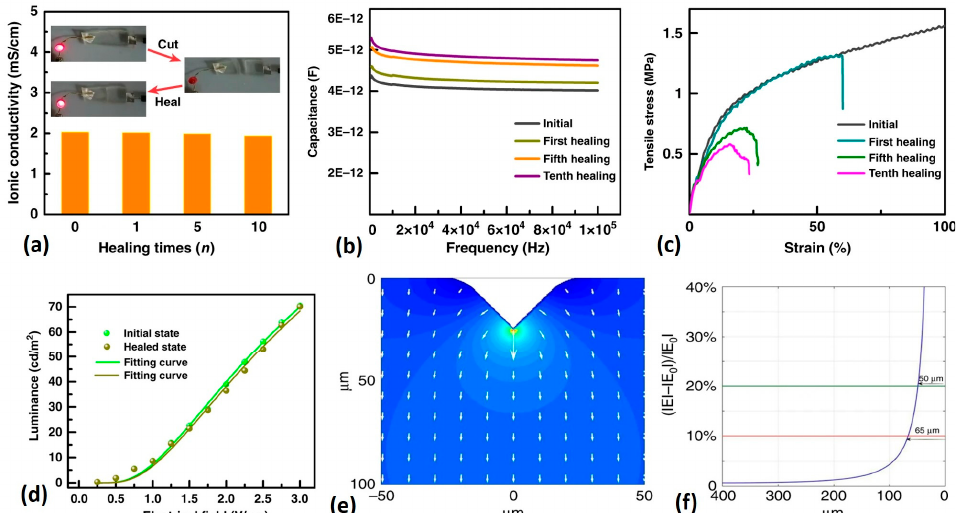
Figure 5. Self-healing and light-emitting performance of electroluminescence devices produced based on polyacrylic acid (PAA)-based hydrogels. ( a ) Ionic conductivity of PAA conductor after lots of cutting and healing times, showing almost full restoration of ionic conductivity after healing. ( b ) Dielectric capacitance after lots of healing and cutting times, which restored dielectric permittivity and capacitance and revealed that light-emitting intensity remains constant after healing. The capacitance of the dielectric layer remained constant after various healing cycles with only a 16.8% increase in capacitance at 1000Hz. ( c ) Mechanical performance of the EL device with the same healing–cutting times shows restoration of 537 kPa in tensile strength and 2.4 MPa in Young’s modulus. ( d ) Voltage-luminescence performance of the EL device at the very beginning states showing high mechanical strength and good flexibility. ( e ) Distribution of the electrical field across the pigment layer (magnified image), showing that the electrical field variation dispersed within the space span. ( f ) Variation in the electric field. Re-printed from an open- access article under the terms of Creative Commons Attribution 4.0 International License of Ref.